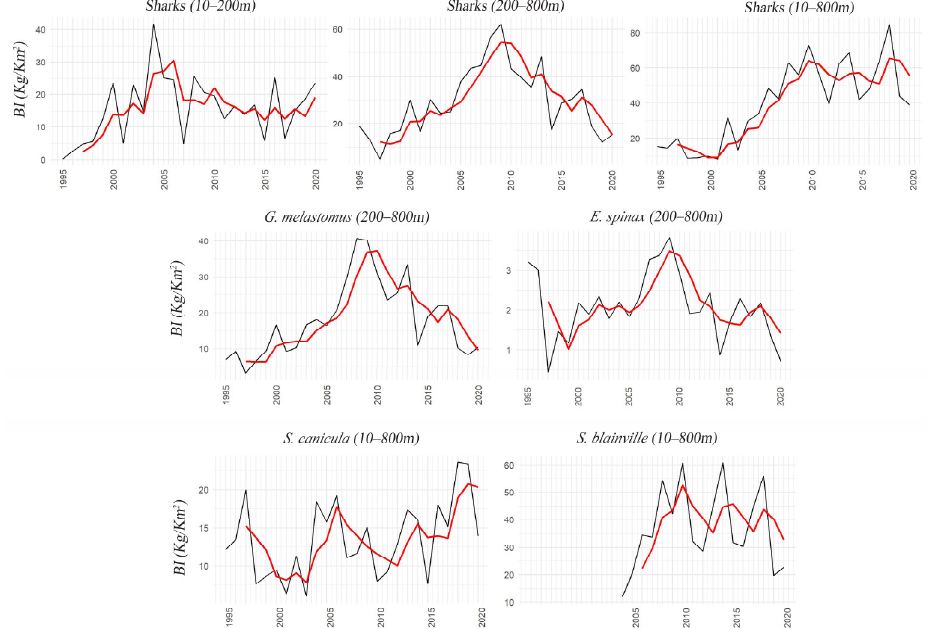
Figure 6. Trend of observed (black lines) MEDITS survey biomass index (kg/km 2 ) over the years and 3-year rolling mean (red lines) for sharks in the Strait of Sicily.